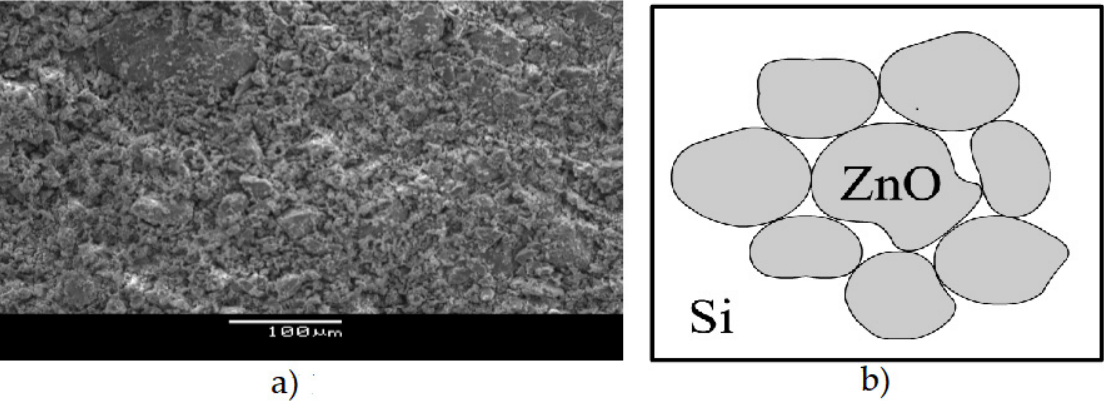
Figure 4. A snapshot of a conglomerate of ZnO grains ( a ) and the structure Si–ZnO nanocomposite ( b ) .